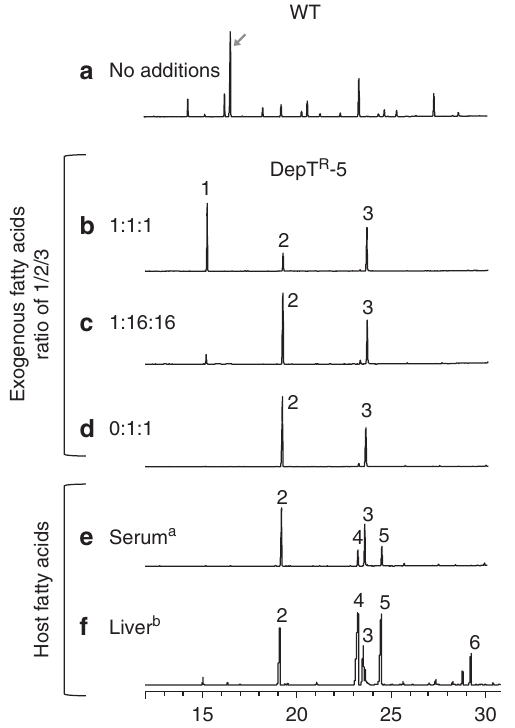
Figure 3 | A S. aureus fabD mutant uses diverse fatty acid combinations for FASII bypass. ( a ) Newman strain in BHI. ( b – f ) Cultures of DepT R -5 were grown in BHI medium supplemented with triclosan and different fatty acid combinations and ratios, as indicated. Fatty acid profiles and OD 600 were determined on cells harvested from 7.5h ( a – e ) and 4.5h ( f ) cultures. a , medium was supplemented with 10% delipidated serum, which lowered toxicity. b , Liver extract, prepared by sterile filtration, was added at a final concentration of 3% (without added fatty acids). The diagonal arrow indicates the position of ai 15:0, the major fatty acid synthesized by S. aureus . Fatty acids are: 1- C14:0; 2- C16:0; 3- C18:1; 4- C18:0; 5- C18:2; 6- C20:4. Proportions of input fatty acids present in supplemented media are indicated at left. Fatty acid profile of liver extract is in Supplementary Fig.